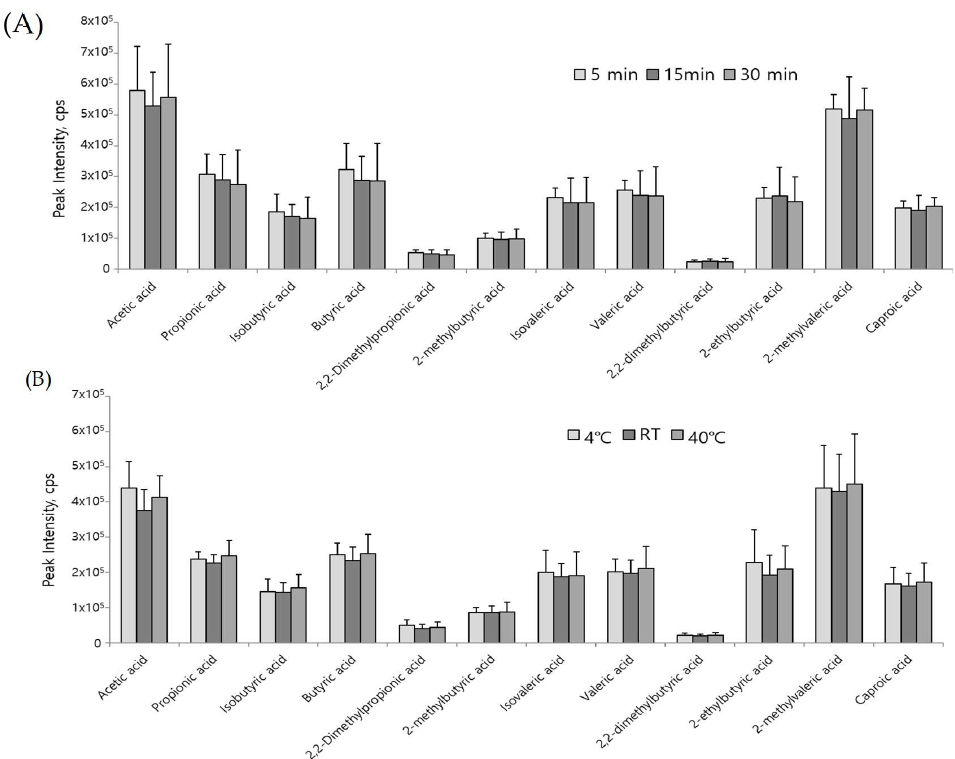
Figure 3. Optimization of derivatization reaction in terms of ( A ) reaction time and ( B ) reaction temperature. Optimized reaction conditions were evaluated using three independent determinations of SCFAs in mouse feces on each condition. Error bar represents the standard deviation of three measurements. RT represents room temperature.